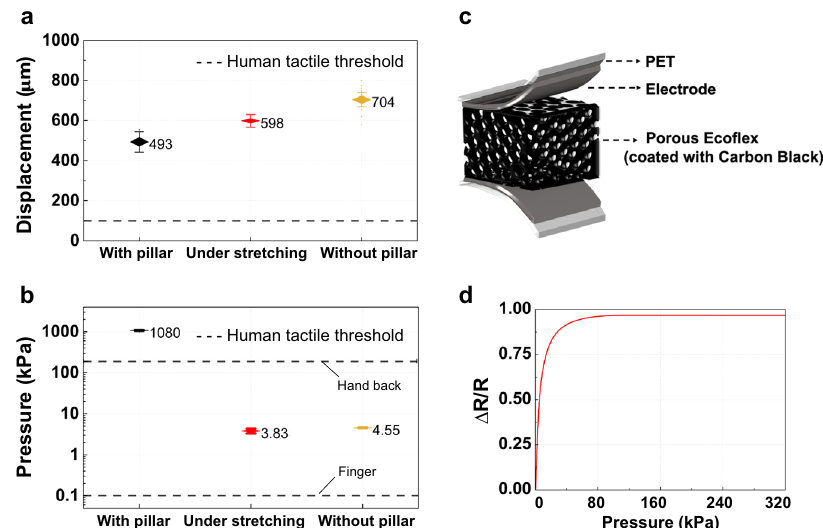
Fig. 6 Actuator and pressure sensor performance. a Measured out-of-plane displacement and b output pressure for actuators with the pressure-ampli fi cation pillar, under 15% tensile strain, and without the pillar. The dashed line in a is the displacement sensation threshold of the skin. The higher dash line in b is the pressure sensation threshold of the hand back and the lower dash line in b is the pressure sensation threshold of the fi nger. Data are presented as mean ± SD. c Schematic illustration of the resistive pressure sensor. d Resistance changes as a function of pressure for the fabricated pressure